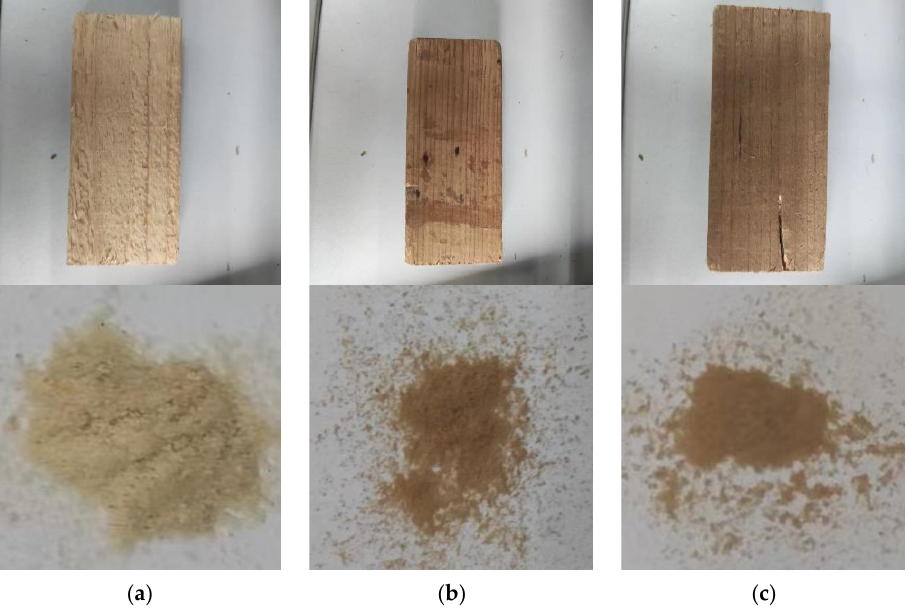
Figure 1. Chinese fir samples with different natural aging times: ( a ) Natural aging — 10; ( b ) Natural Chinese fir samples with different natural aging times: ( a ) Natural aging—10; aging — 70; ( c ) Natural aging — 100. ( b ) Natural aging—70; ( c ) Natural